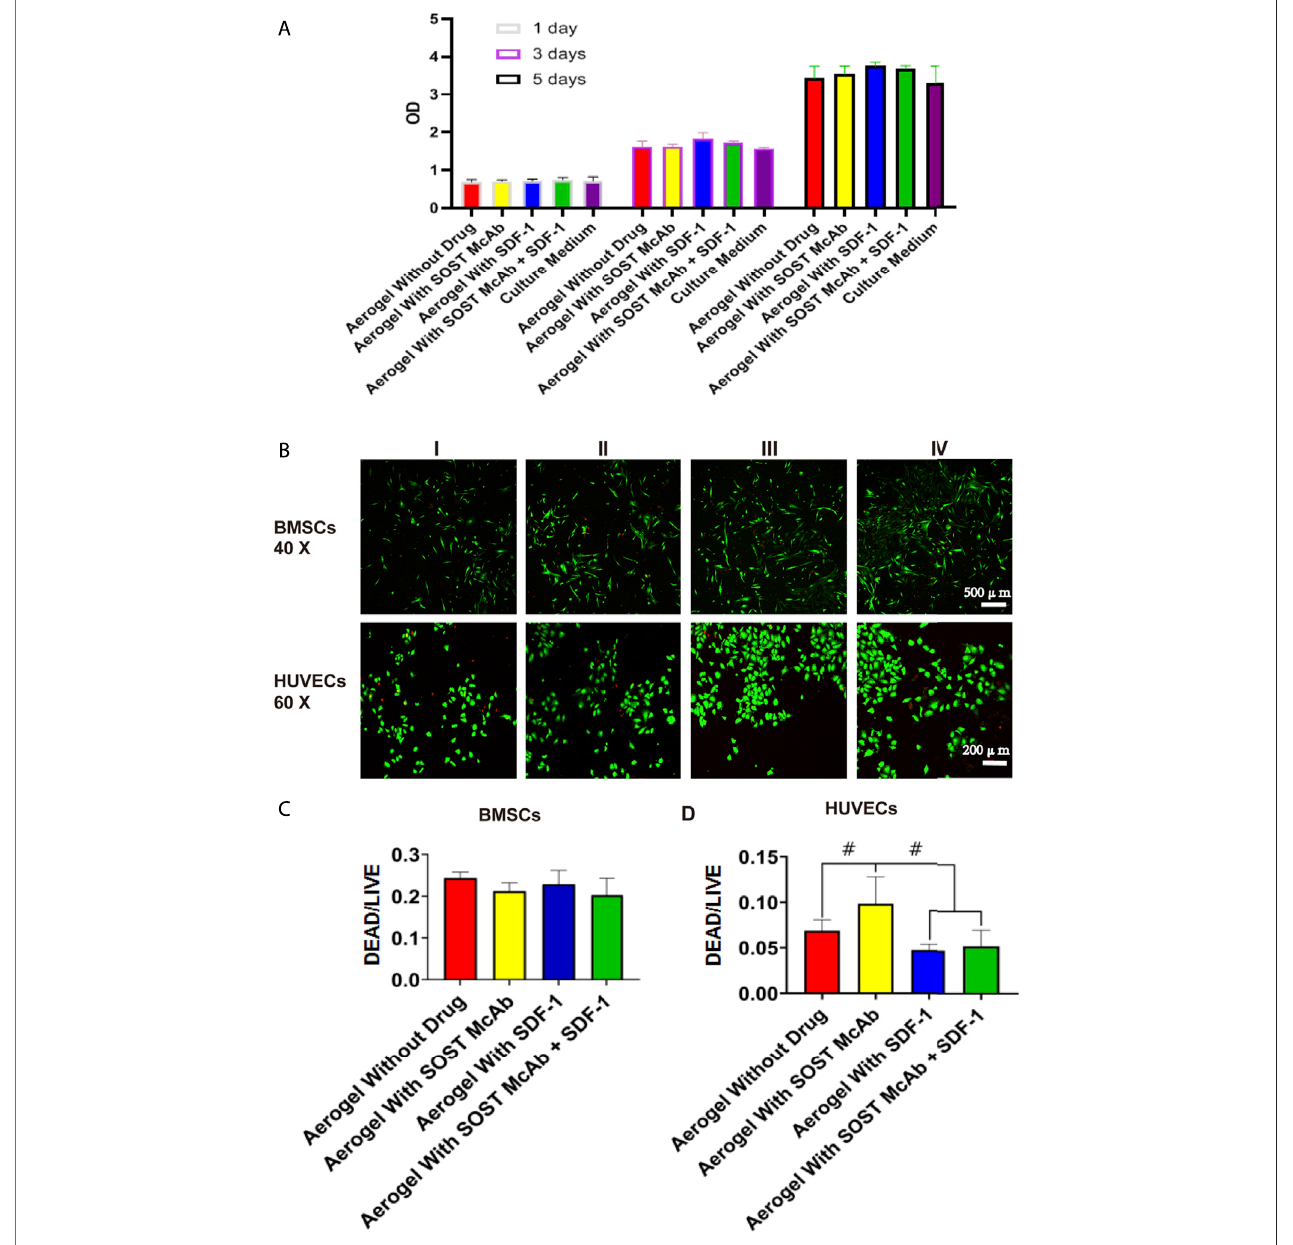
FIGURE 3 | The cell activity evaluation and the result of live/dead assay of the NCF-Col-NHA aerogel scaffold in vitro. Cell activity evaluation. When the extract of NCF-Col-NHA aerogel scaffolds with different drugs was co-cultured with BMSCs, the relative proliferation rate of BMSCs was between 97% and 113% (A) , these aerogel scaffolds had no cytotoxicity (B – D) . The result of live/dead assay. The BMSCs and HUVECs grow well on the aerogel scaffolds, the ratio of dead/living cells is lowerthan10%.GroupI,aerogelscaffoldwithoutloadingdrugs;GroupII,aerogelscaffoldloadedwithSOSTMcAb;GroupIII,aerogelscaffoldloadedwithSDF-1; Group IV, aerogel scaffold loaded with SOST McAb + SDF-1. BMSCs, bone marrow mesenchymal stem cells; HUVECs, Human umbilical vein endothelial cells. #, p ＜